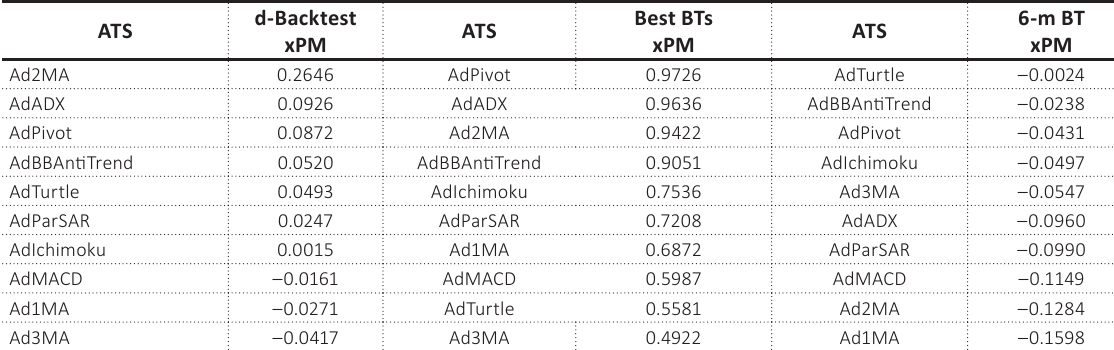
Table B1. Total results for Extended Profit Margin (xPM)